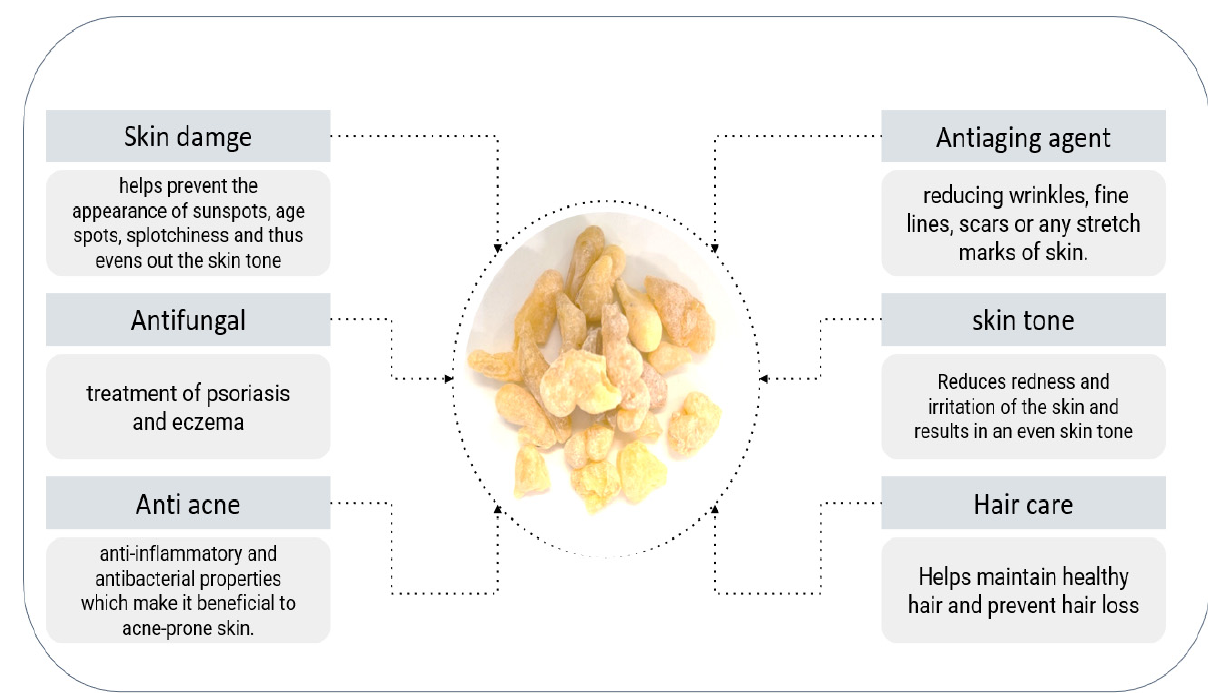
Figure 4. The illustrated summary of the cosmetic uses of B. Serrata .